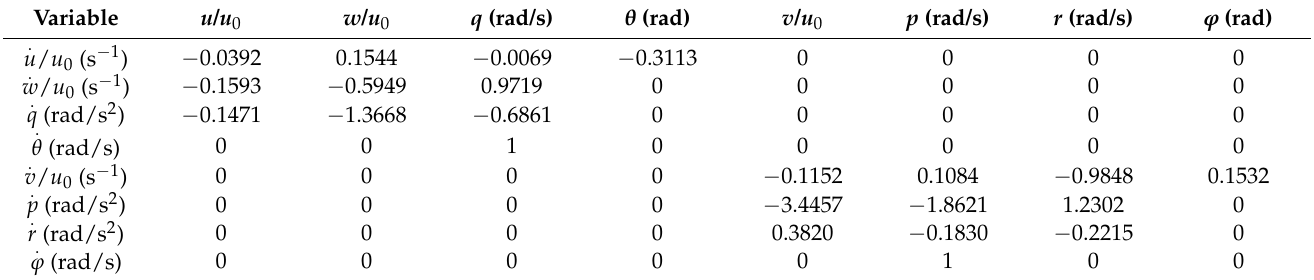
Table 8. Baseline 8 × 8 stability matrix for flight condition 12 in Table 4.